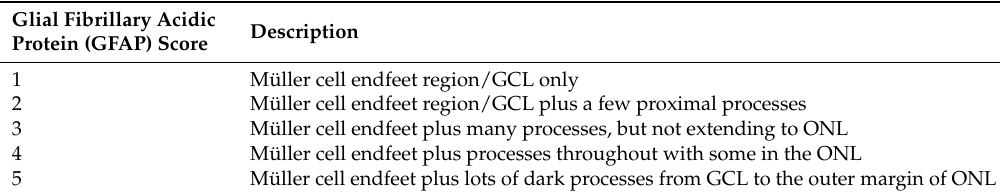
Table 4. Scoring system to evaluate glial